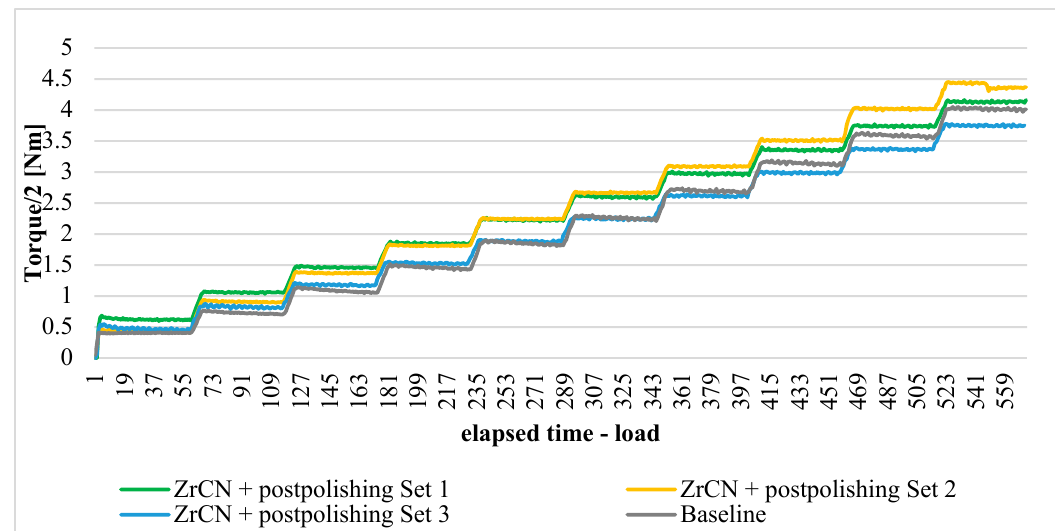
Figure 16. 594A/592A ZrCN + polish post-processing TTR friction test 0–15 kN, 30 rpm. Figure 16. 594A / 592A ZrCN + polish post-processing TTR friction test 0–15 kN, 30 rpm.